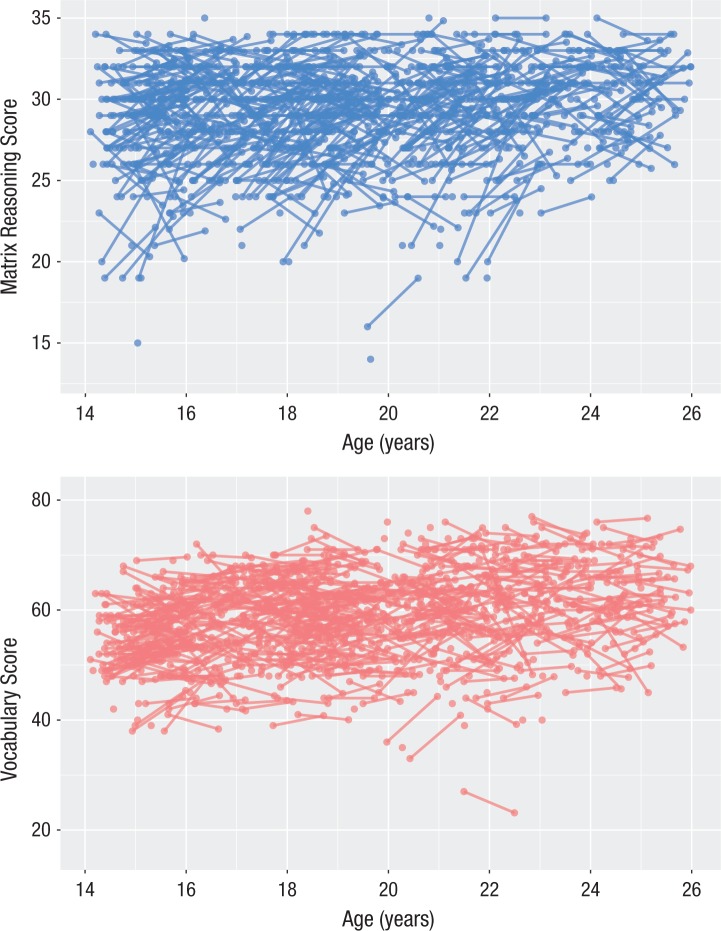
Scatterplots showing the association between age and score on the Matrix Reasoning subtest (top) and Vocabulary subtest (bottom) of the second edition of the Wechsler Abbreviated Scale of Intelligence (Wechsler, 2011). Lines connect the rescaled scores of those individuals who completed the test at both waves.